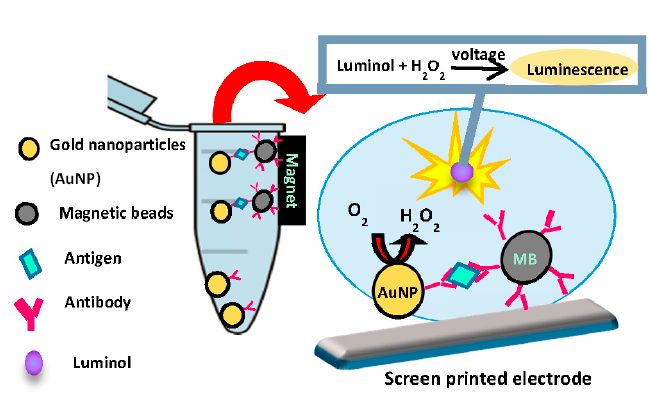
Figure 2. Schematic of biosensing application of AuNP